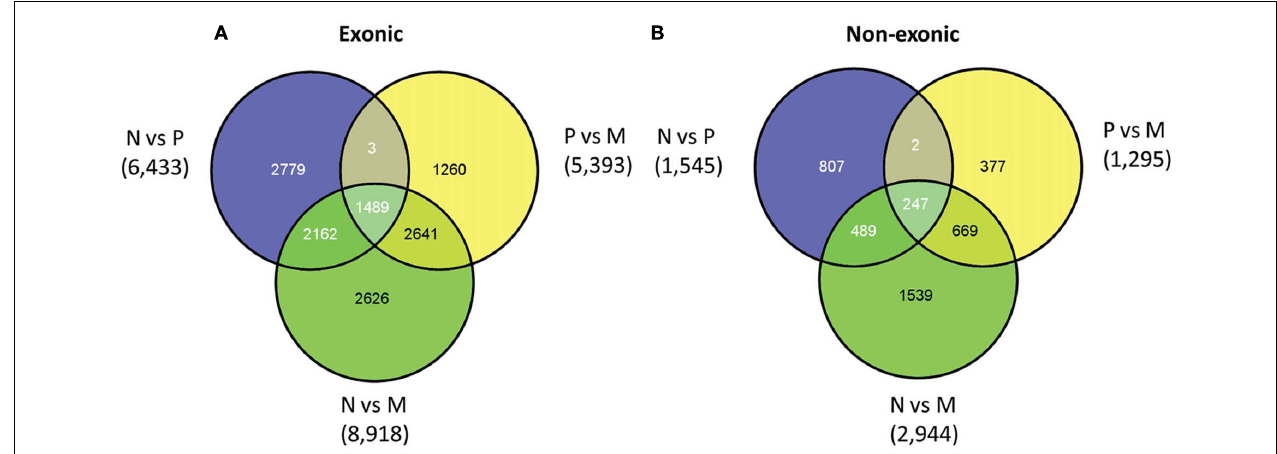
Features in the NCTRANSCRIPT slice of each pie chart (left) are assessed for their overlap with non-coding transcripts to generate the distribution of transcripts (shown at the right for each pairwise comparison). AS, antisense. UTR, untranslated region; lincRNA, long intergenic ncRNA.